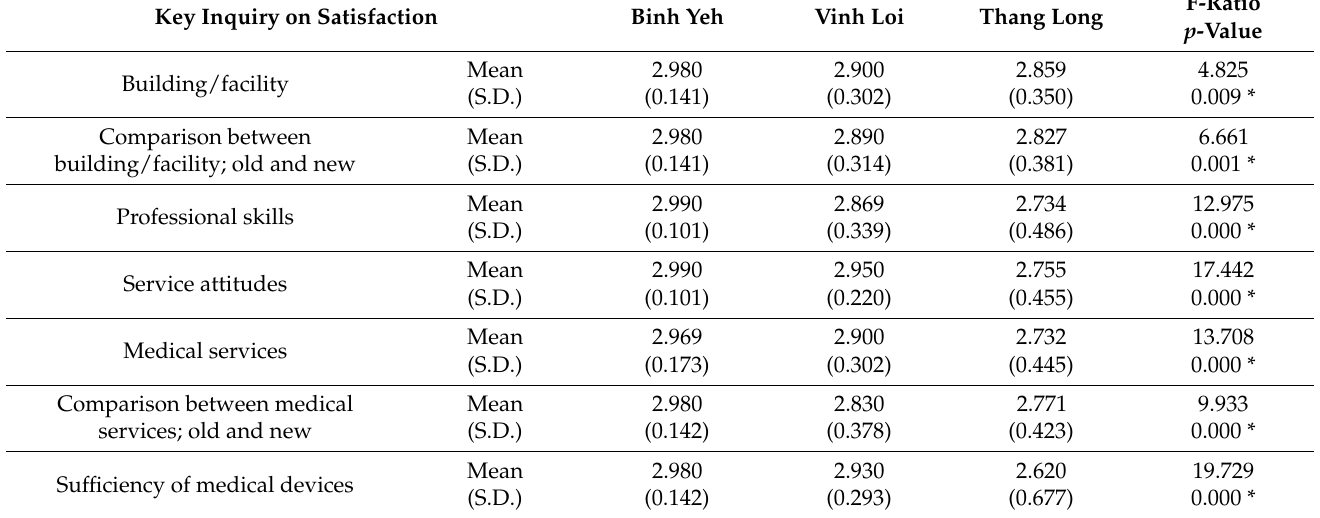
Table 7. Comparison of the patient satisfaction-relevant key inquiry between the three regions